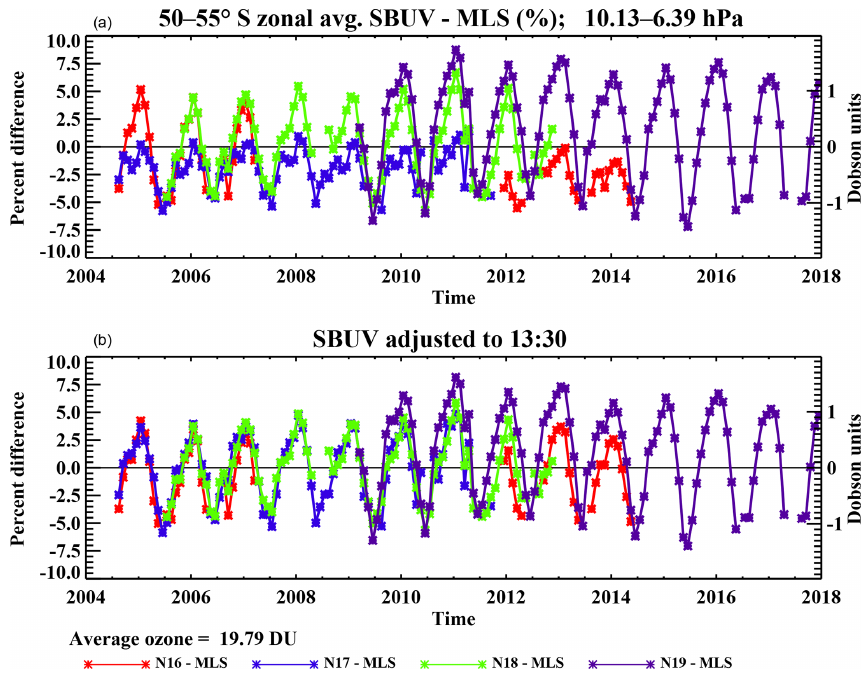
Figure 12. Same as Fig. 10 but for the 50–55 ◦ S latitude band at 10–6.4hPa layer.